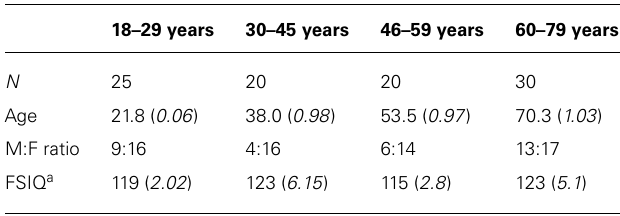
Table 1 | Participant characteristics in each of the age groups (standard error in